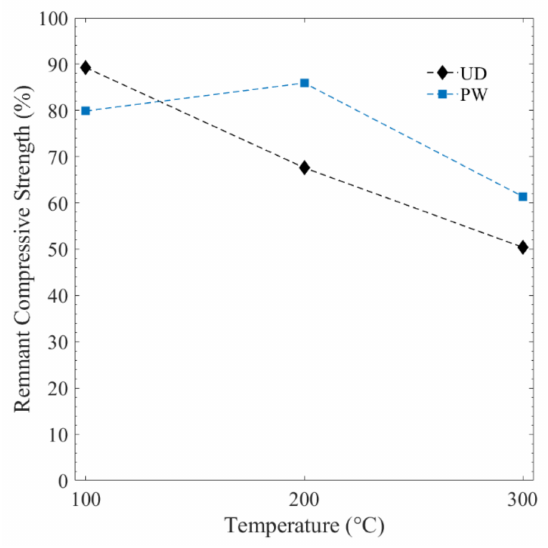
Figure 4. Remnant compressive strength (expressed as a percentage of strength at room temperature) of PW and UD PT 30 composites.